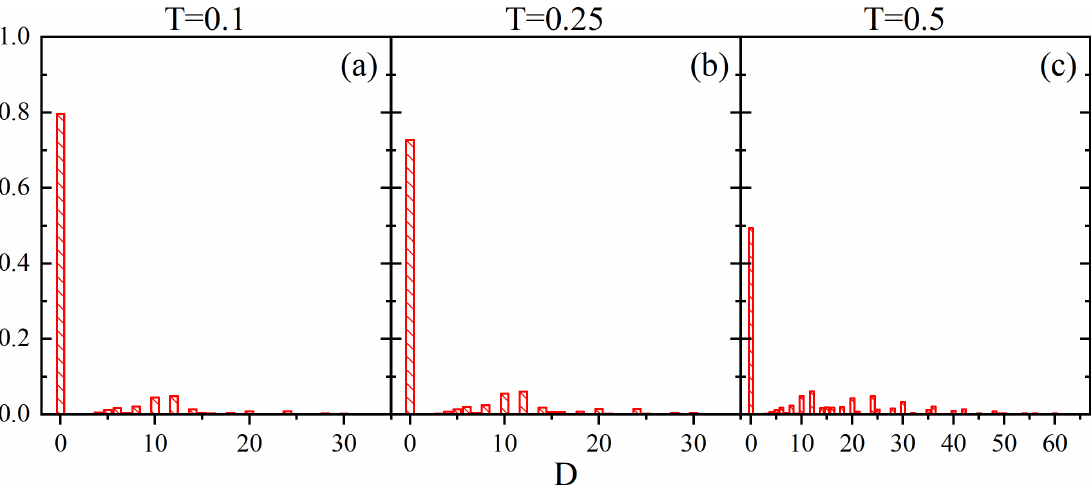
Figure 12. Empirical probability distributions ρ ( D ) : T = 0.1 ( a ), T = 0.25 ( b ) and T = 0.5 ( c